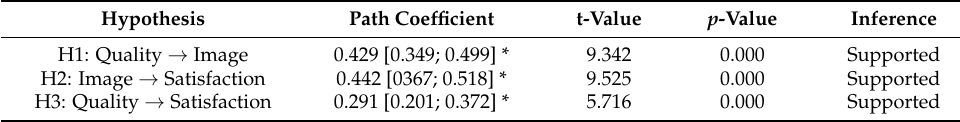
Table 5. Results of the analysis of direct effects in the hypothesized model.